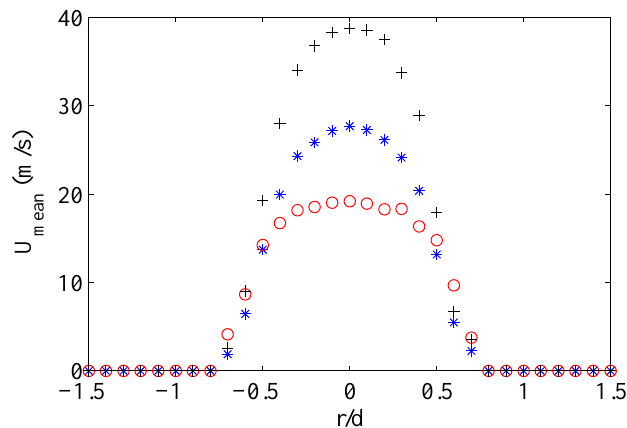
Figure 5. Jet velocity profiles in the radial direction for different discharged energy. Red markers are the results for E d = 1.2 mJ ( S = 12.36), blue ones for E d = 2.1 mJ ( S = 11.01), and black ones for E d = 3.4 mJ ( S =